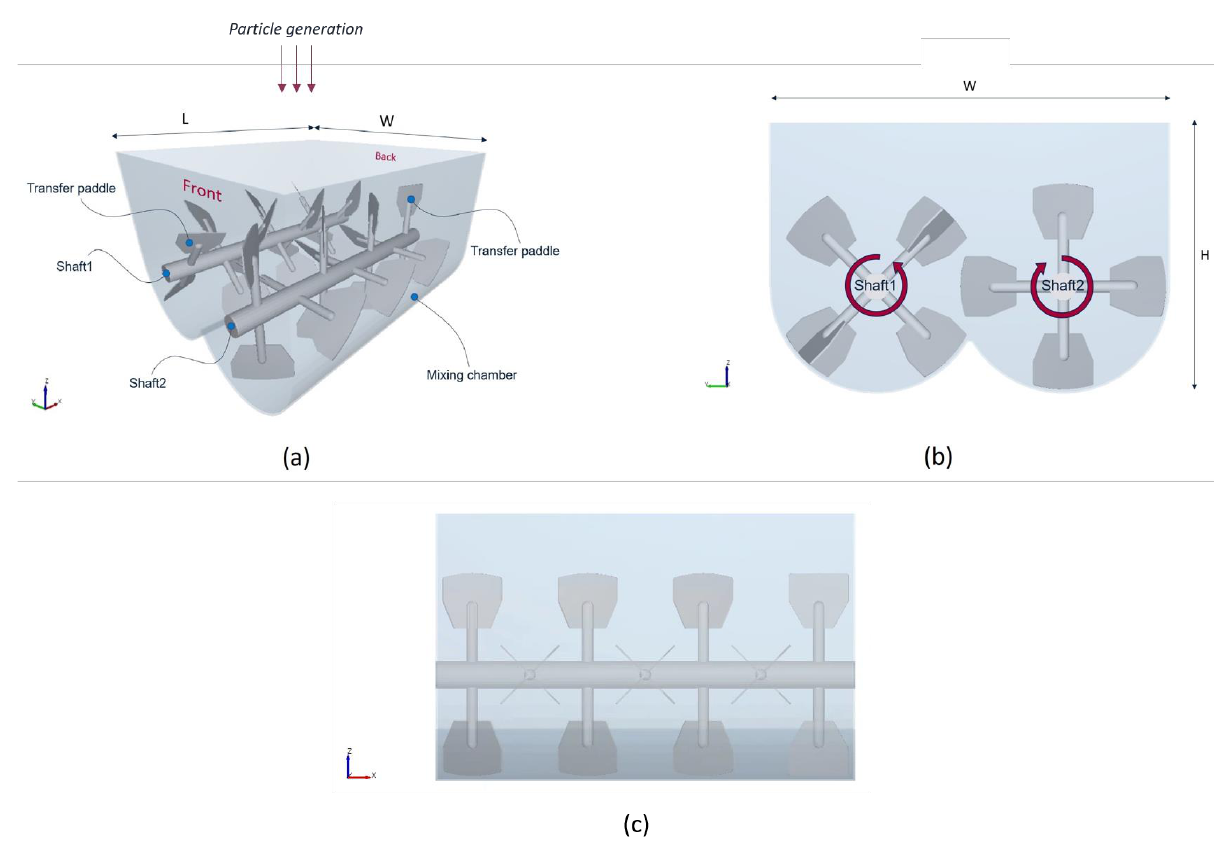
Figure 1. ( a ) Isometric view, ( b ) front view and ( c ) side view of the paddle mixer. For clarity, only shaft 2 is shown in the side view.